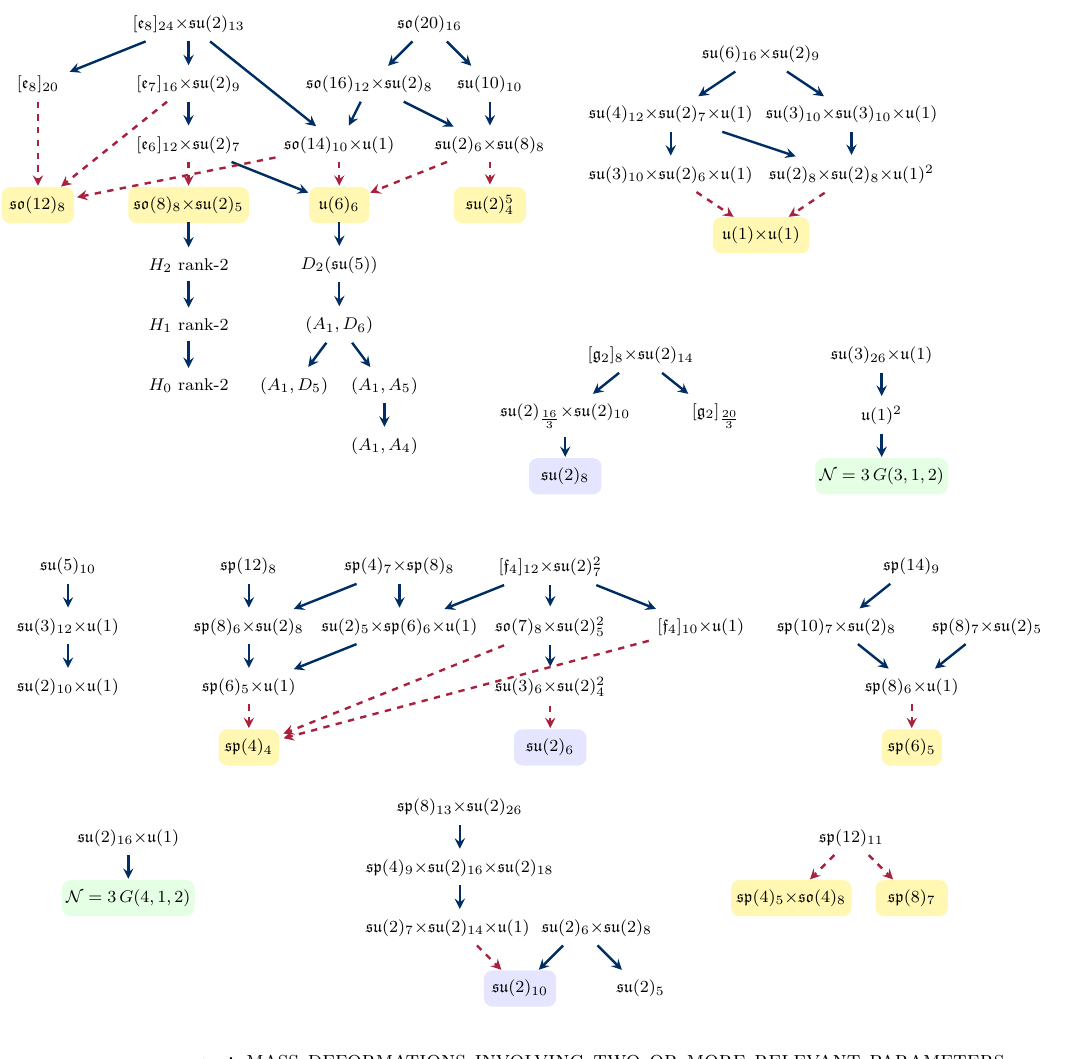
Figure 1 . Graphical depiction of the RG-relations among four dimensional N = 2 SCFTs. We shade in yellow N = 2 Lagrangian theories, in green N = 3 theories and in blue N = 4 theories. All theories but two N = 3 theories are labeled by their flavor